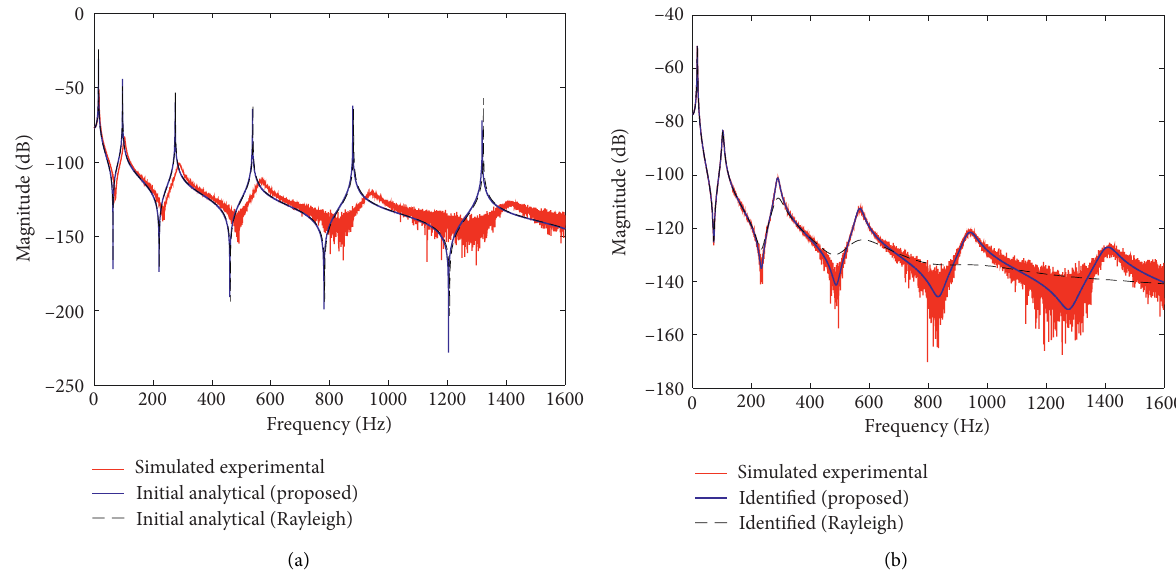
Figure 8: Comparison of simulated and analytical FRFs H